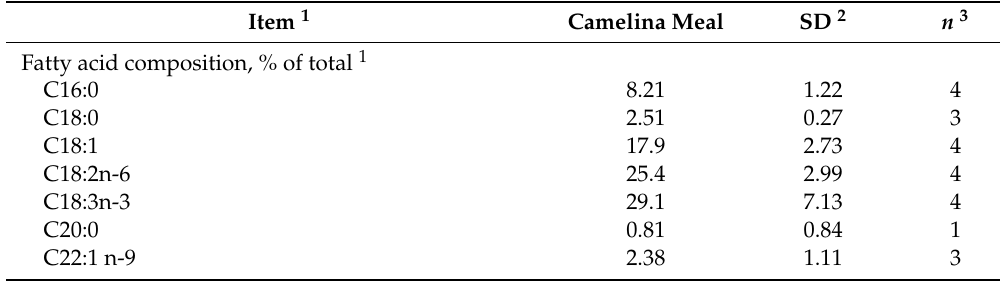
Table 5. Fatty acids composition (% of total fatty acids) of camelina meal (CMM).